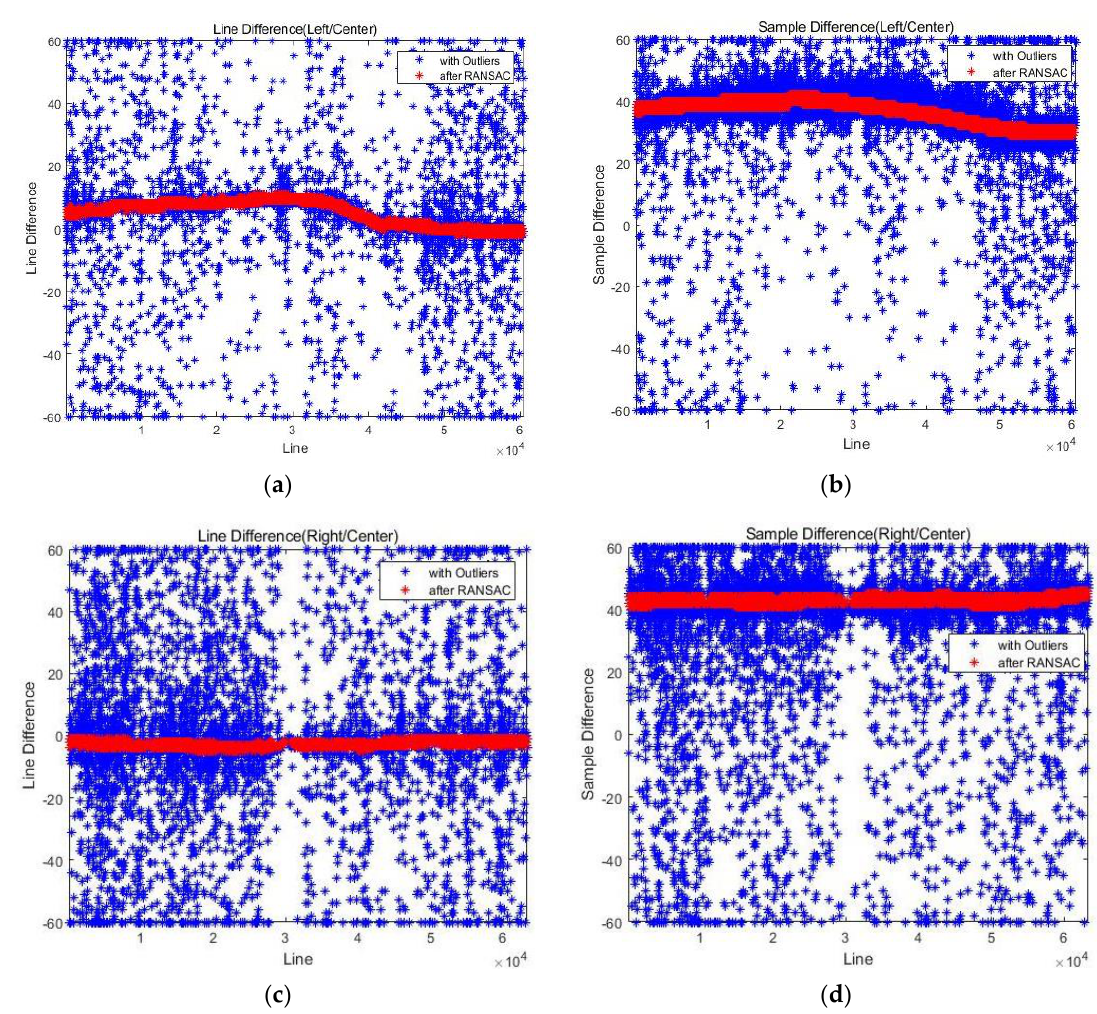
Figure 8. Discrepancy between the image coordinates in the matching pair — ( a ) line difference between Strips #1 and #2; ( b ) sample difference between Strips #1 and #2; ( c ) line difference between Strips #2 and #3; ( d ) sample difference between Strips #2 and #3.